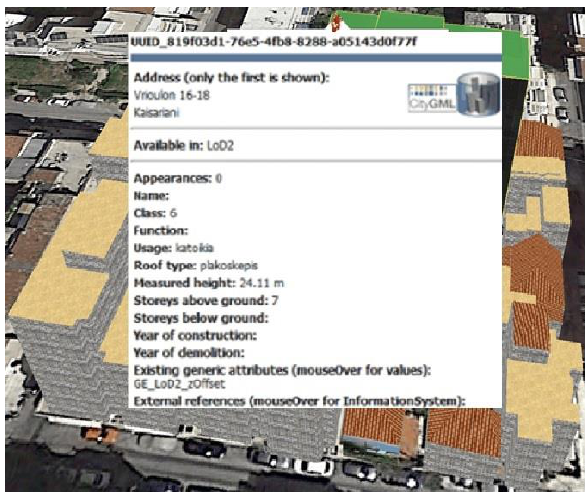
Figure 4. Balloon of a 3D Building in Google Earth